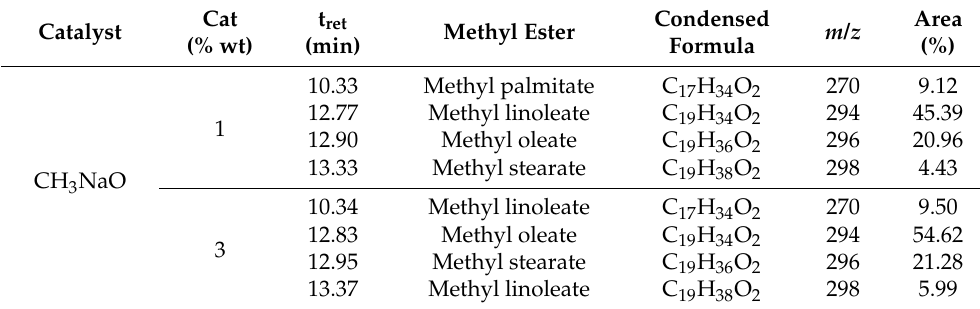
Table 4. Results of the GC–MS analysis of the biodiesel produced using the homogeneous catalyst CH 3 NaO at 1 and 3